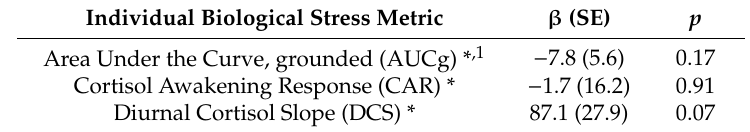
Table A1. Resultsofthreeindependentmodelsofbiologicalstressmeasures(AreaUndertheCurve, Diurnal Cortisol Slope, Cortisol Awakening Response) and infant birth weight in full-term births ( ≥ 37